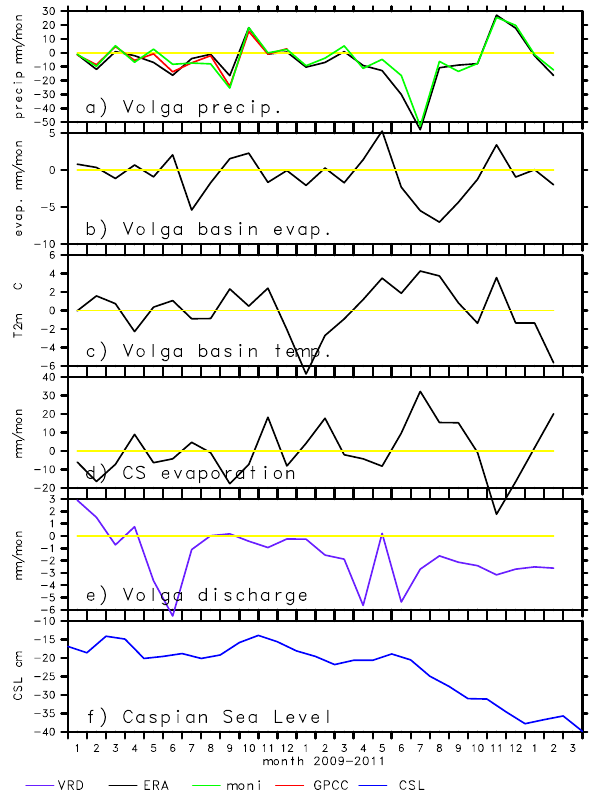
Fig. 4. Same as Fig. 1 but for 2009 to 2011 only and no